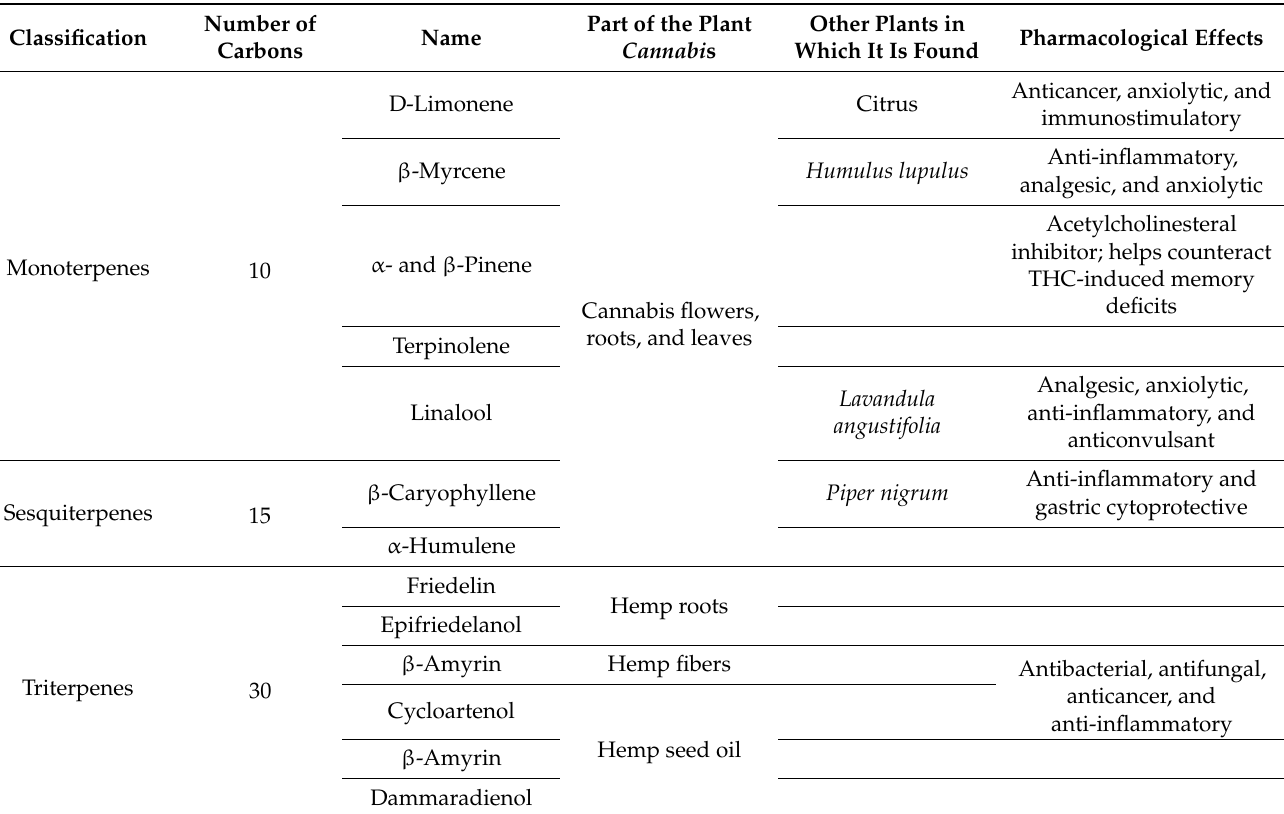
Table 1. Terpenes found in Cannabis sativa . Classification according to the number of carbons, the part of the plant where they are located, and some of their pharmacological